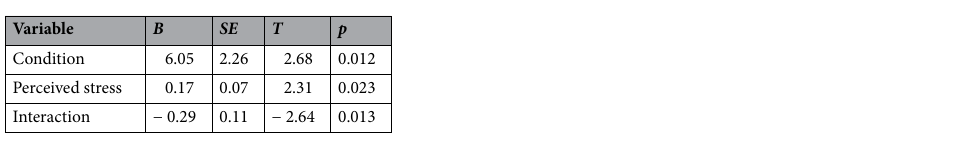
Table 3. Regression model for Study 2 moderation analysis. B is the unstandardized